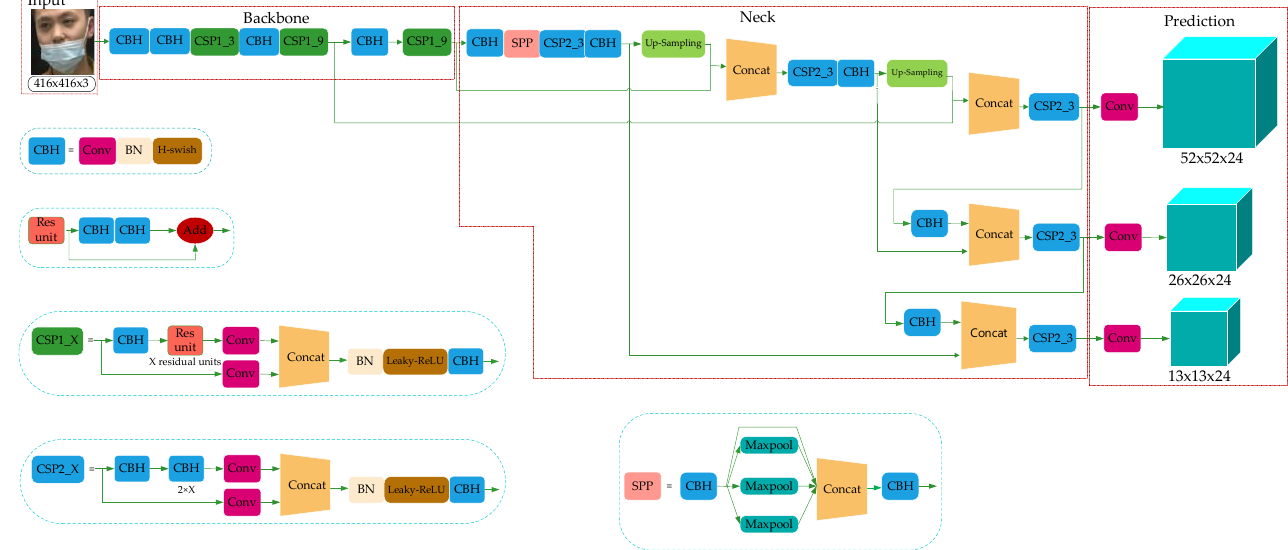
Figure 8. Network model of mask detection.